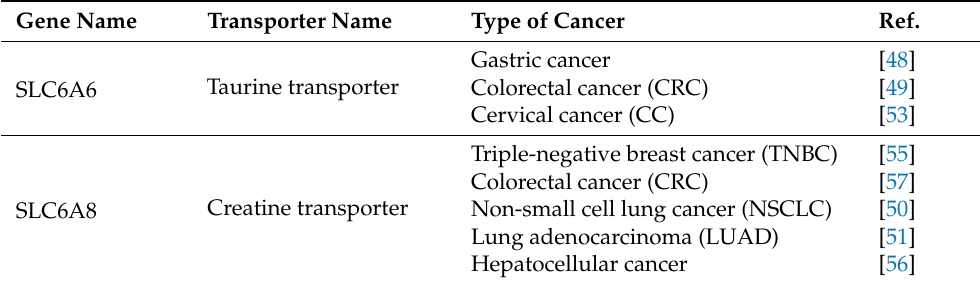
Table 2. Taurine and creatine transporters are associated with several types of